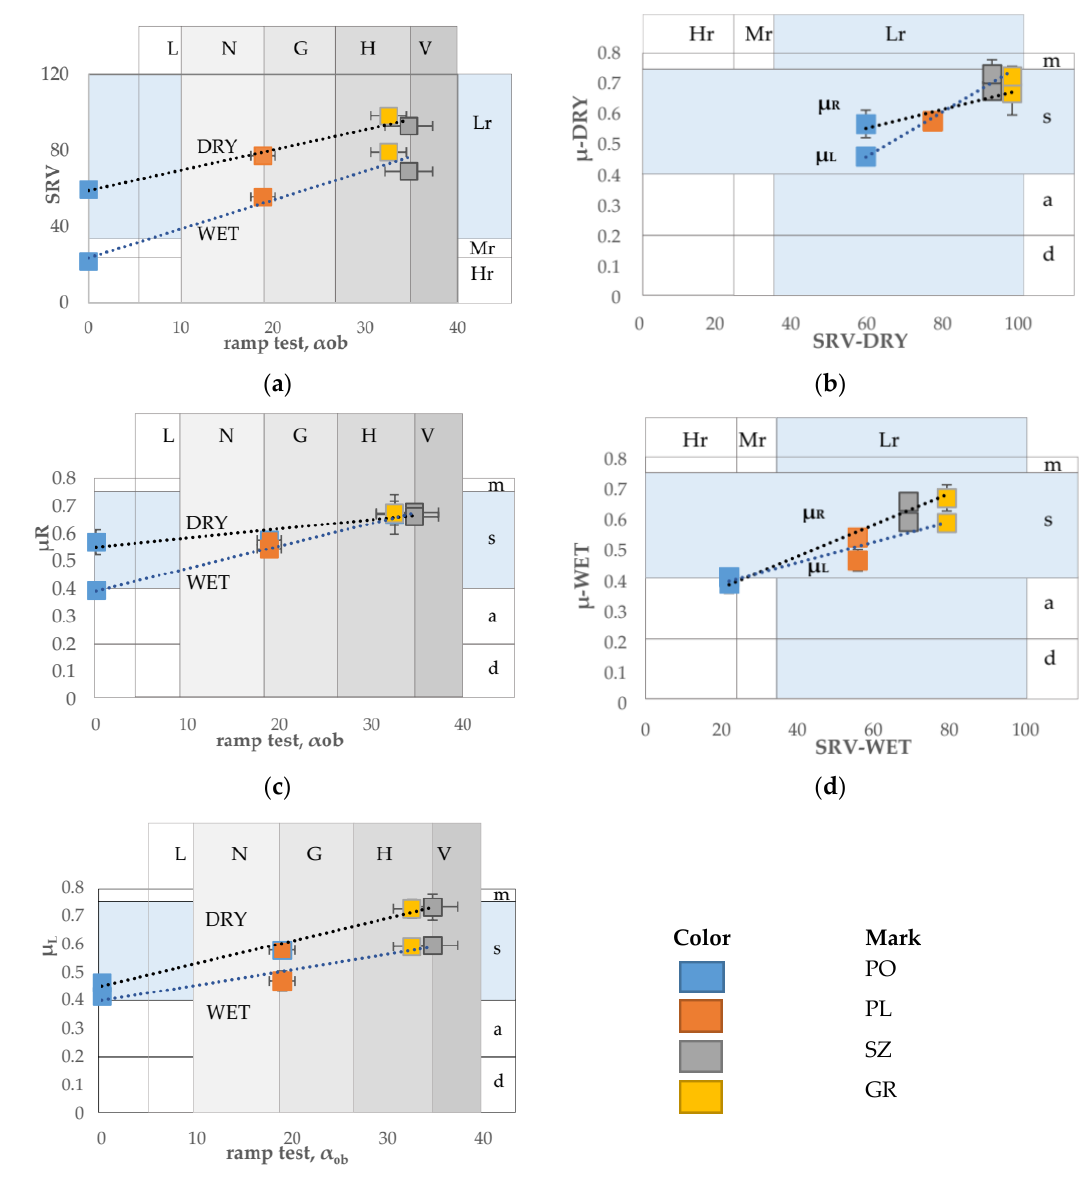
Figure 13. Slip evaluation for four surfaces (PO, PL, SZ, and GR) depending on the test method and associated classification criteria. ( a ) SRV for dry and wet surfaces versus α ob results of the ramp test. ( b ) Sliding friction coefficient using rubber slider ( µ R ) for dry and wet surfaces versus results of the ramp test. ( c ) Sliding friction coefficient using leather slider ( µ L ) for dry and wet surfaces versus results of the ramp test. ( d ) Dry surface µ R and µ L versus SRV. ( e ) Wet surface µ R and µ L versus